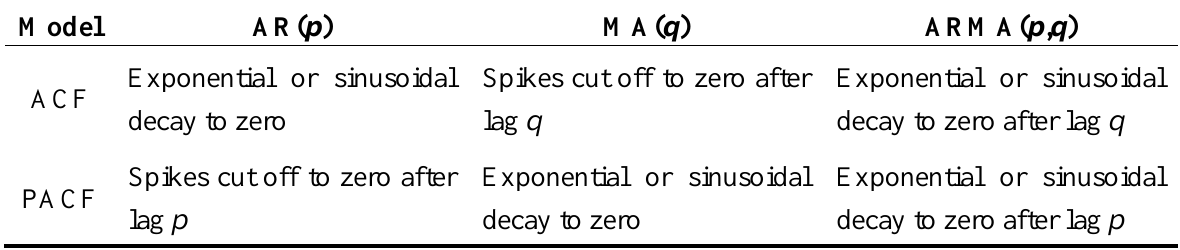
Table 1. Patterns in the theoretical ACF and PACF of stationary time series.